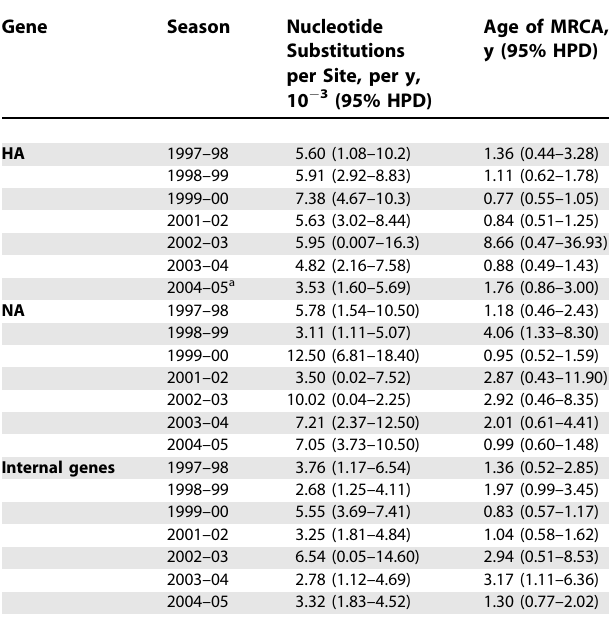
Table 1. Nucleotide Substitution Rates and Ages of MRCA